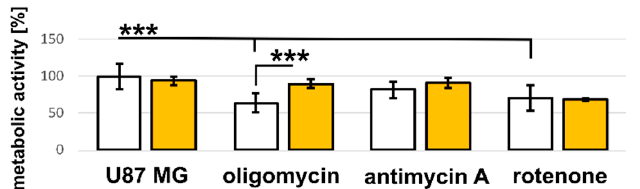
Figure 8. Metabolic activity of U87 MG cells exposed to hypericin and respiratory chain regulators: oligomycin, antimycin A, and rotenone. Histogram bars represent cells treated with each regulator (white) and in combination with hypericin (yellow). The error bars represent the standard deviation from the mean values. The level of significant difference was evaluated using one-way ANOVA test *** p < 10 − 6 .